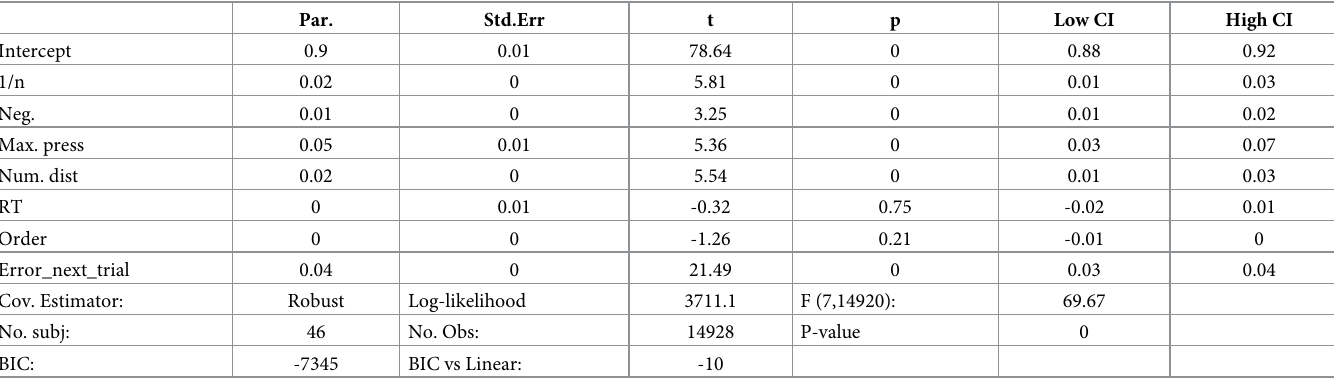
Table 2.1. Accuracy. Exp. 2 . Random Effects Estimation.